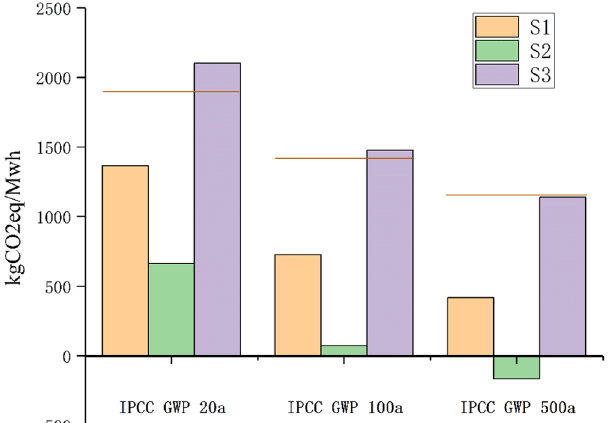
Figure 3. GHG impacts in various time horizon of each system based on IPCC methods in comparison with market electricity under the same functional unit conditions.